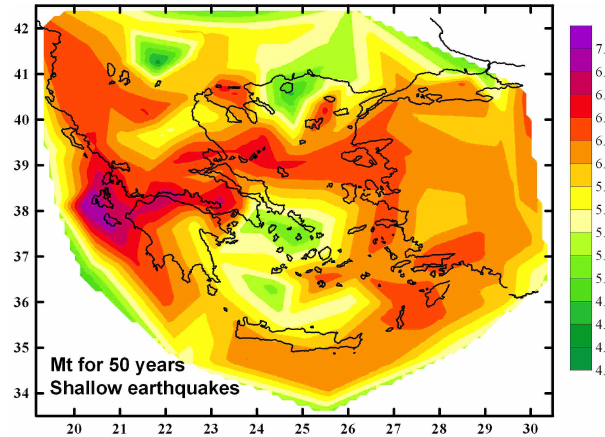
Figure 12. Spatial distribution of mean return period, T m , for shal- low earthquakes of magnitude M ≥ 6.0 within the broader Aegean area.